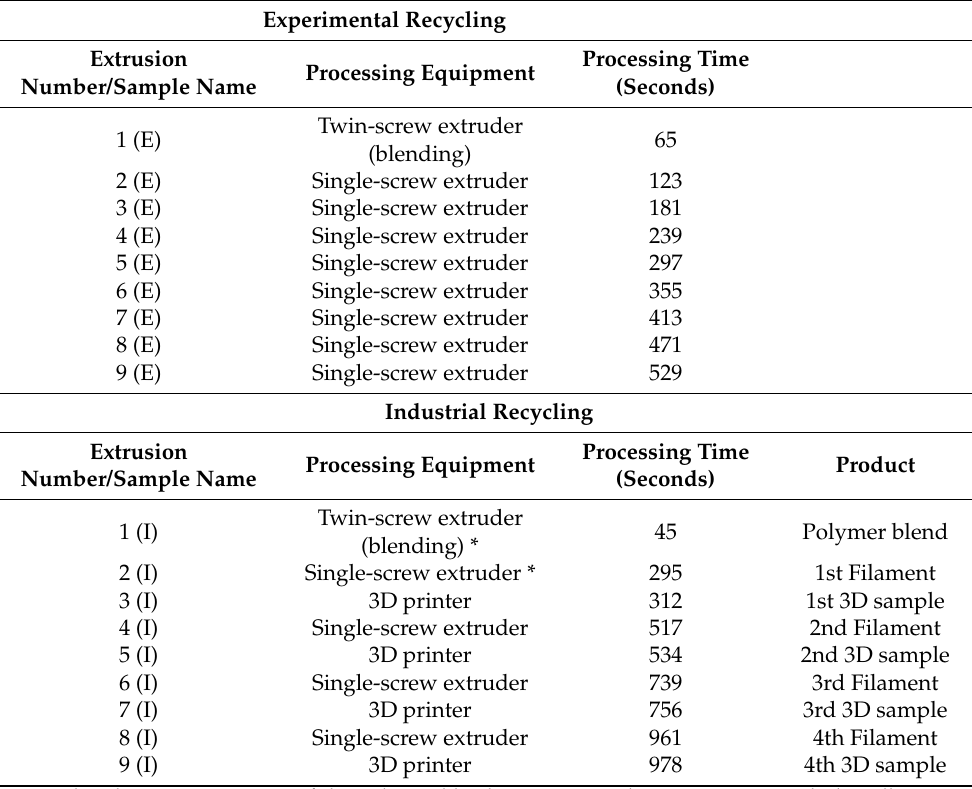
Figure 1. The process of mechanical recycling in experimental and industrial conditions. Table 1. Processing passes of the PLA/PHB blend suitable for 3D printing.